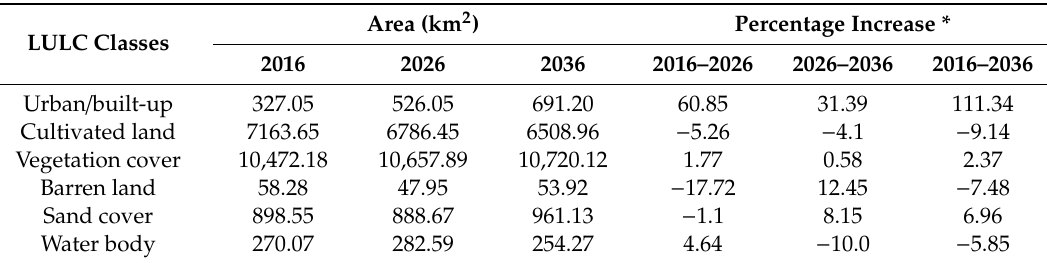
Table 3. Area of changes during 2016, 2026, and 2036.